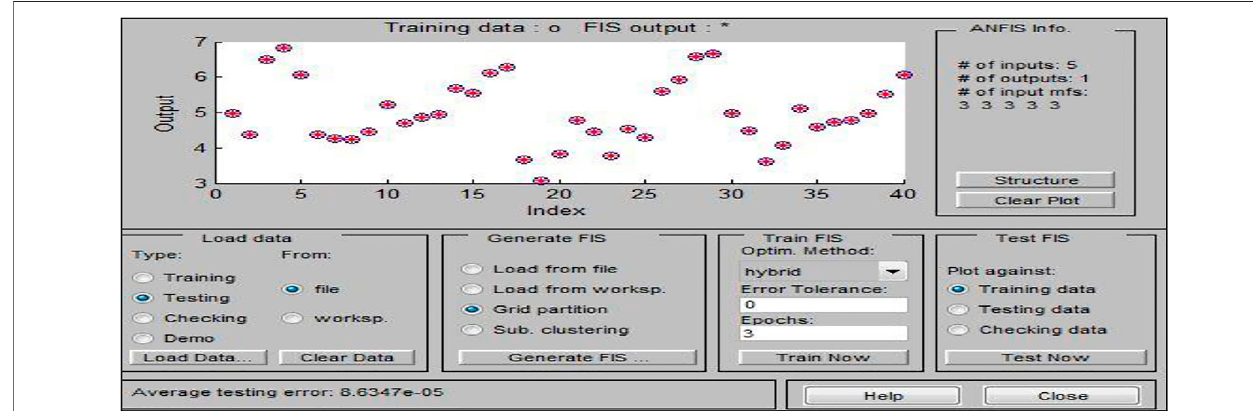
FIGURE 8 | Training and testing of the ANFIS model.